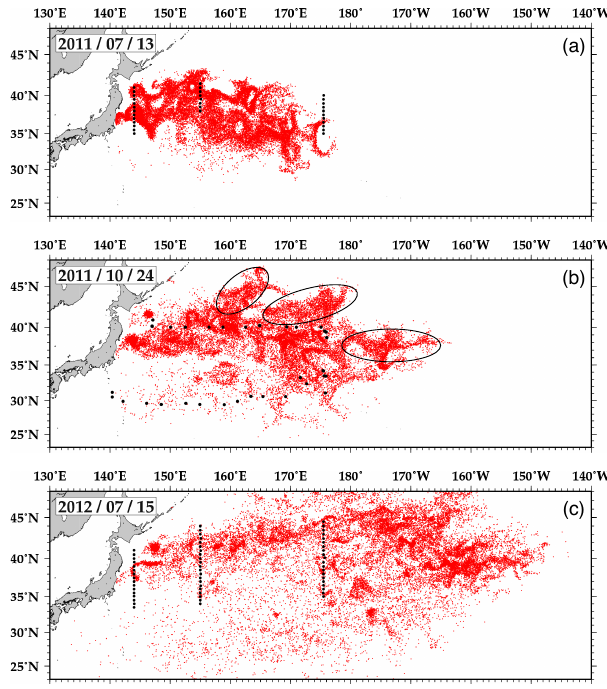
Fig. 3. The result of particle tracking experiment at the median date of each sampling period. Red circles indicate pseudo-particle, and black circles indicate sampling locations: (a) 13 July 2012, (b) 24 October 2011, and (c) 15 July 2012.